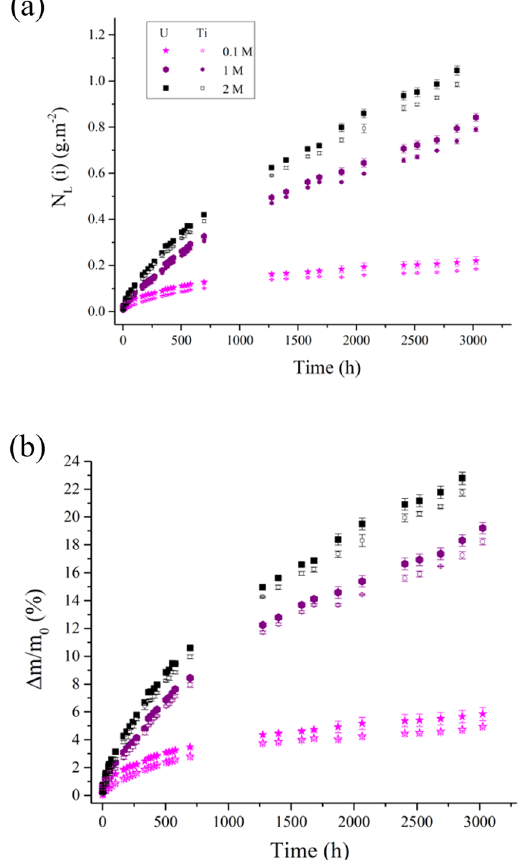
Fig. 6 Dissolution of brannerite in H 2 SO 4 solutions with 2.8 g/L of Fe(III) at 25 °C. Evolution of the normalized weight losses N L (i) (g/m 2 ) ( a ) and of the relative mass losses Δ m i / m 0 (%) ( b ) obtained during the dissolution of synthetic brannerite samples in various H 2 SO 4 solutions containing 2.8 g/L of Fe(III) at 25 °C.